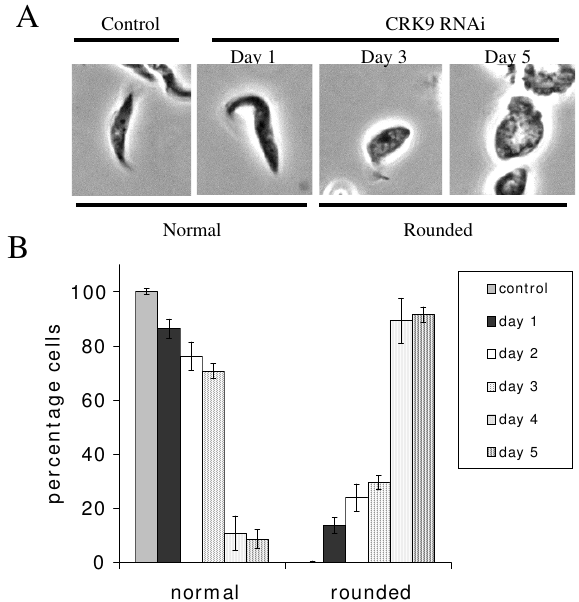
Figure 2 Morphology of CRK9 depleted cells . The control cells (without RNAi induction) and the cells depleted of CRK9